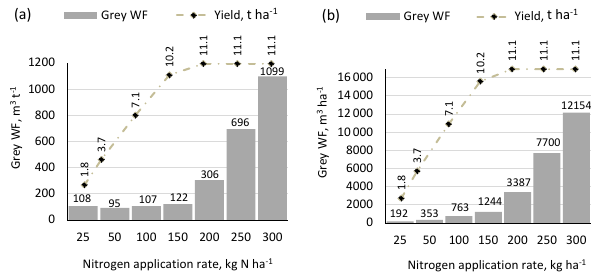
Figure 3. Grey WF of maize production in m 3 t − 1 (a) and m 3 ha − 1 (b) for a range of N application rates under the reference management